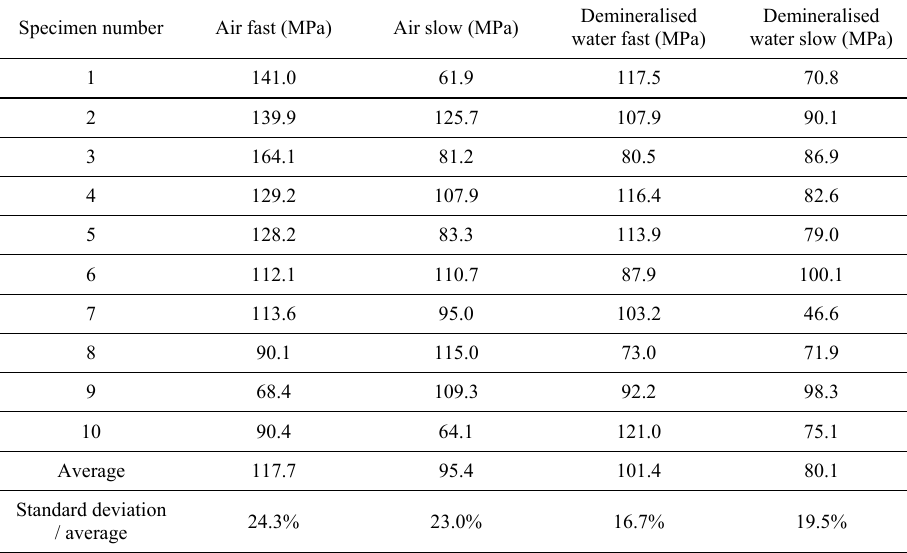
Table 1: Tests in air and demineralised